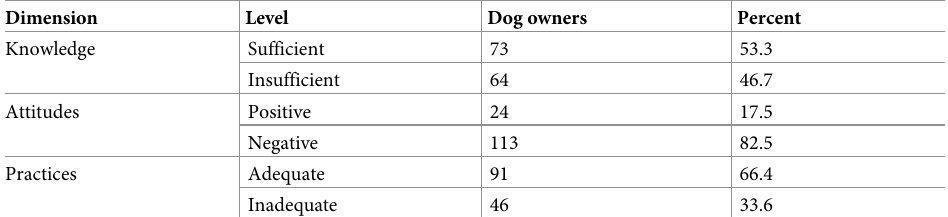
Table 4. Knowledge, attitudes and practices towards rabies among dog owners in Kigali City (n =